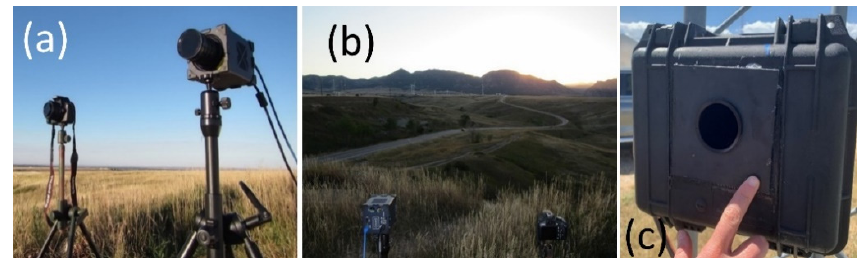
Figure 3. Two types of specialized cameras were used to periodically image turbines from afar and confirm and visualize dim UV illumination of wind turbine surfaces ( a , b ). Time-lapse, long-expo- sure landscape camera captured nightly images of the UV-illuminated turbines throughout the study period ( c ). Images by Paul